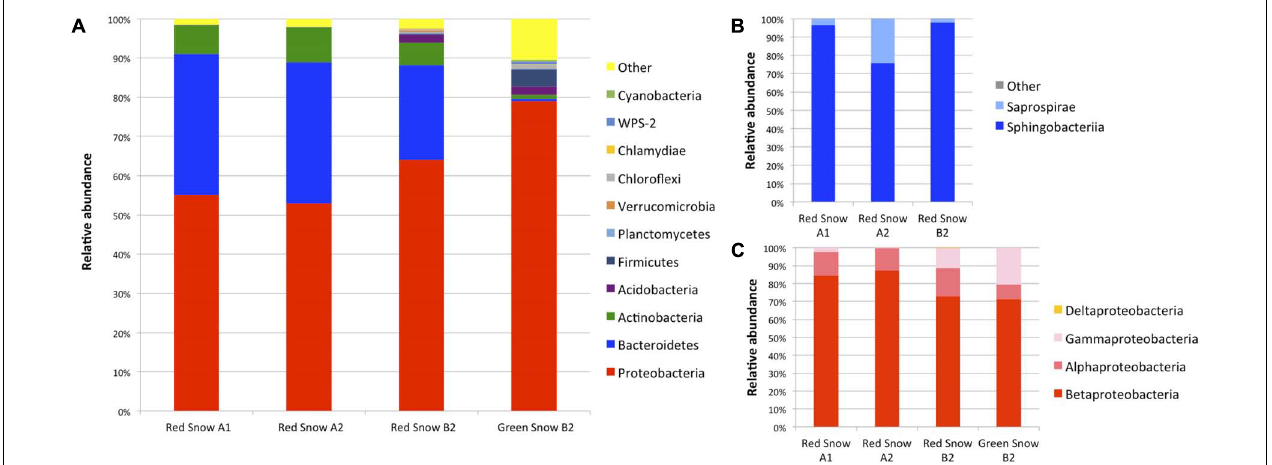
FIGURE 5 | Bacterial community composition based on 16S rRNA gene sequencing of three red snow samples (red snow A1, A2, and B2) and one green snow sample (green snow B2) from Mt. Asahi. (A) Community composition of the OTUs grouped at the phylum level. (B) Composition of the Bacteroidetes phylum for the red snow samples. (C) Composition of the Proteobacteria phylum for the red and green snow